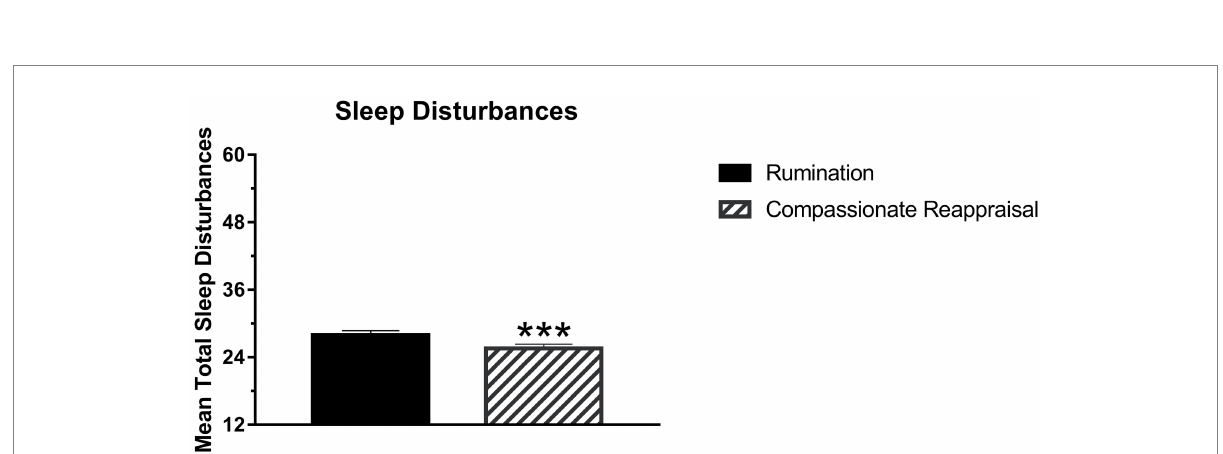
FIGURE 3 Total sleep disturbances as measured by the Sleep Disturbances Questionnaire (SDQ) were significantly lower following compassionate reappraisal ( M = 25.57, SEM = 0.77) compared to rumination ( M = 27.95, SEM = 0.81), F (1, 169) = 11.70, p < 0.001. Error bars indicate Standard Error of the Mean (SEM). The y-axis gives the minimum to maximum score on the SDQ. ***Indicates p < 0.001.